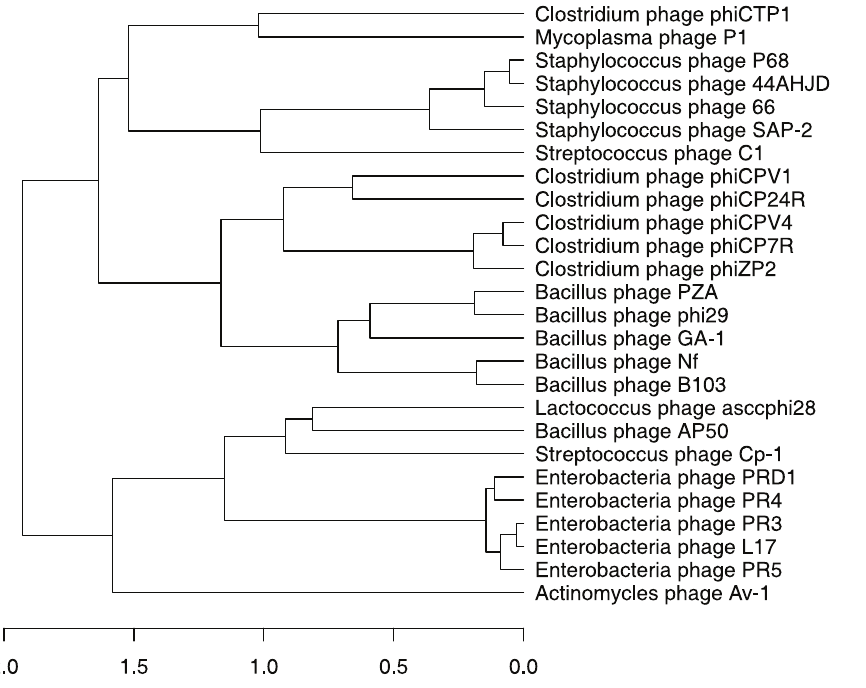
Figure 7. Whole-genome Similarities as Determined by Tetranucleotide Frequencies. Dendrogram is based on a dissimilarity matrix for whole bacteriophage genomes constructed in R as described in the methods section.